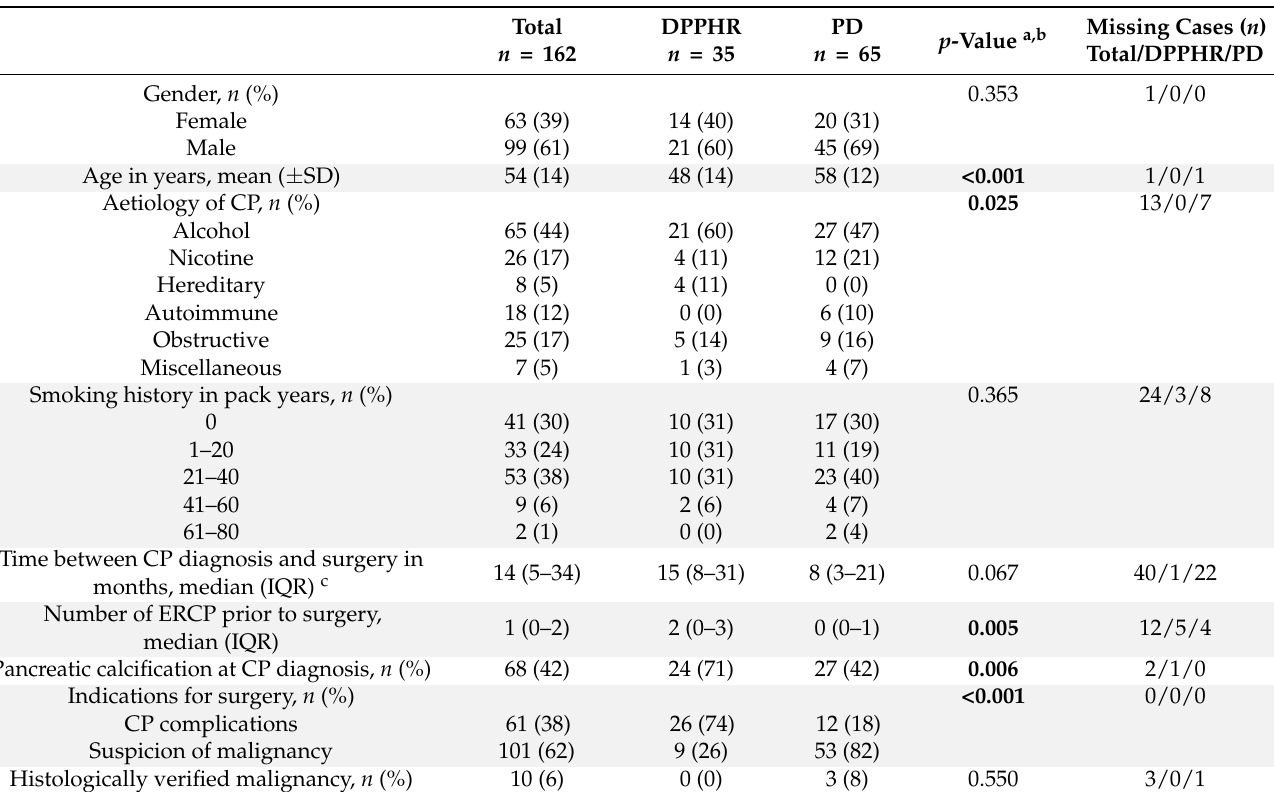
Table 1. Patient characteristics in the total population among duodenum-preserving pancreatic head resection (DPPHR) and pancreaticoduodenectomy (PD). Total DPPHR PD Missing Cases ( n ) p -Value a,b n = 162 n = 35 n = 65 Total/DPPHR/PD 0.353